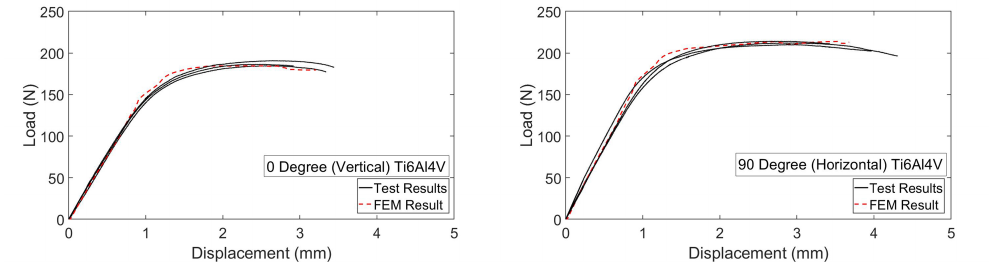
Figure 15. Load-deflection curves for 0 ◦ and 90 ◦ build orientation specimens in the bending